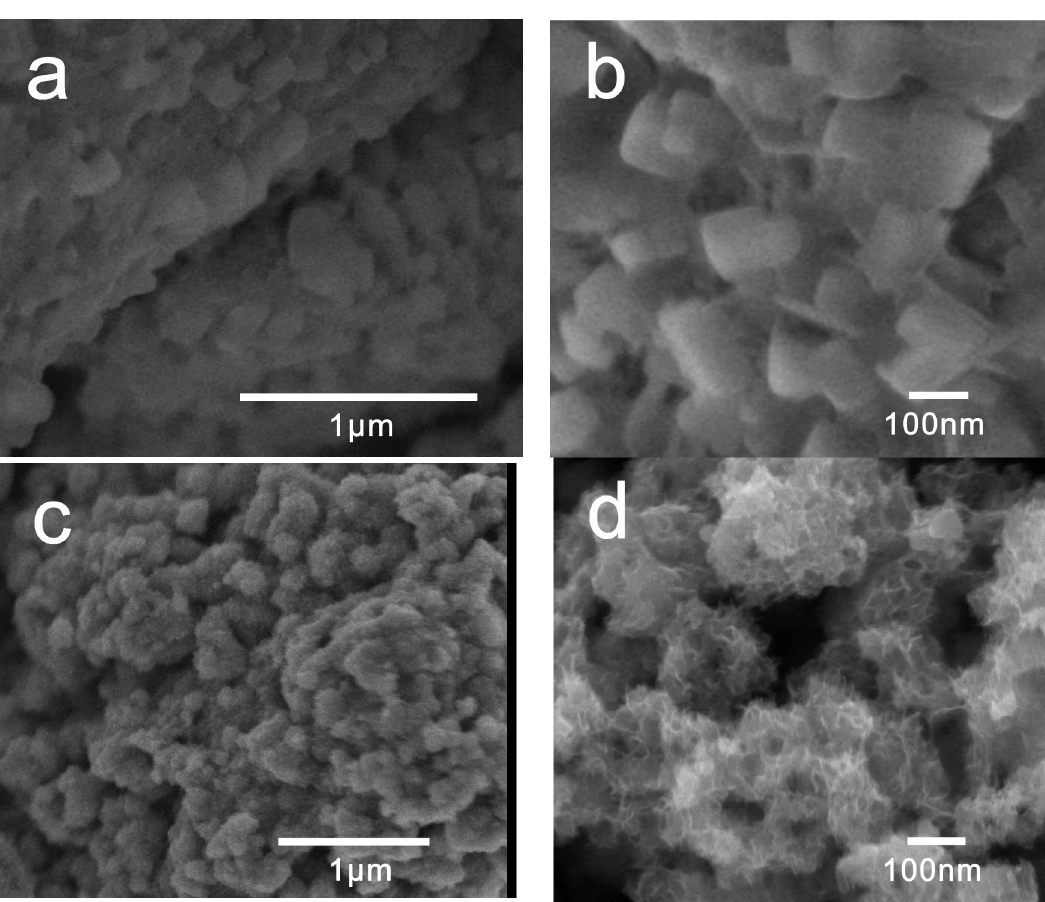
Figure 2. SEM of as-synthesized samples: ( a , b ) TiOF 2 ; and ( c , d ) NaOH-modified TiOF 2 .